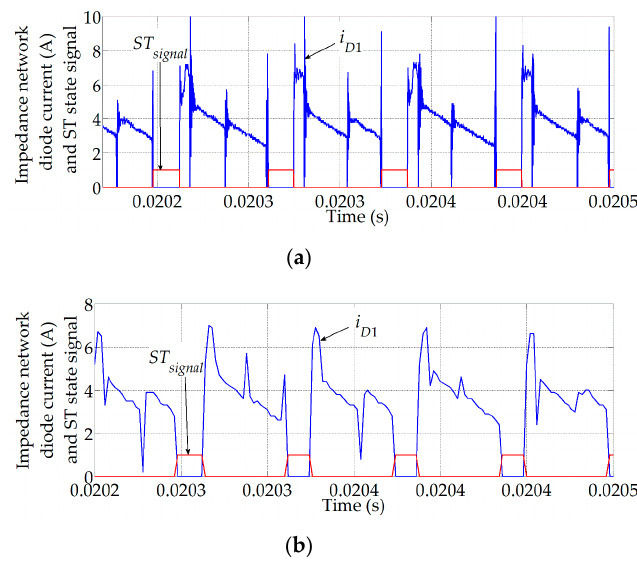
Figure 5. Waveforms of the impedance network diode current and the ST signal for the switching frequency of 8 kHz and sampling frequencies of 10 MHz ( a ) and 500 kHz ( b ). frequency of 8 kHz and sampling frequencies of 10 MHz ( a ) and 500 kHz ( b ).